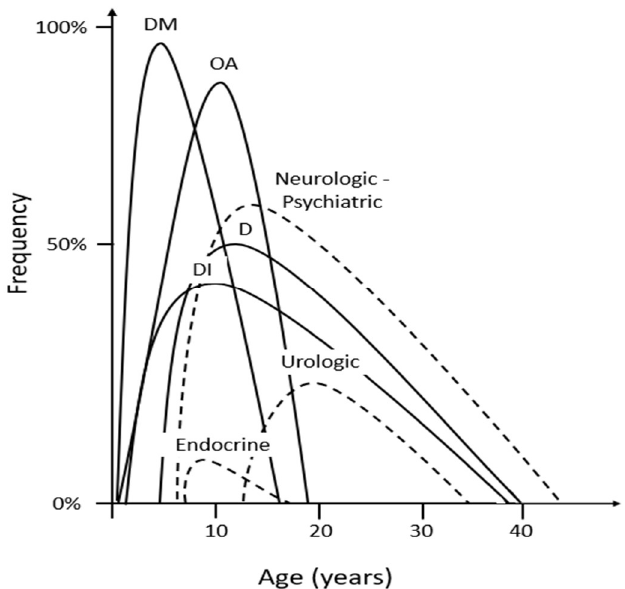
Figure 1. Prevalence of various features of WS1 (main features with continuous and secondary features with dashed line) and the age at which these features are diagnosed according to data from reference [36]. D: deafness, DI: diabetes insipidus, DM: diabetes mellitus, OA: optic atrophy.